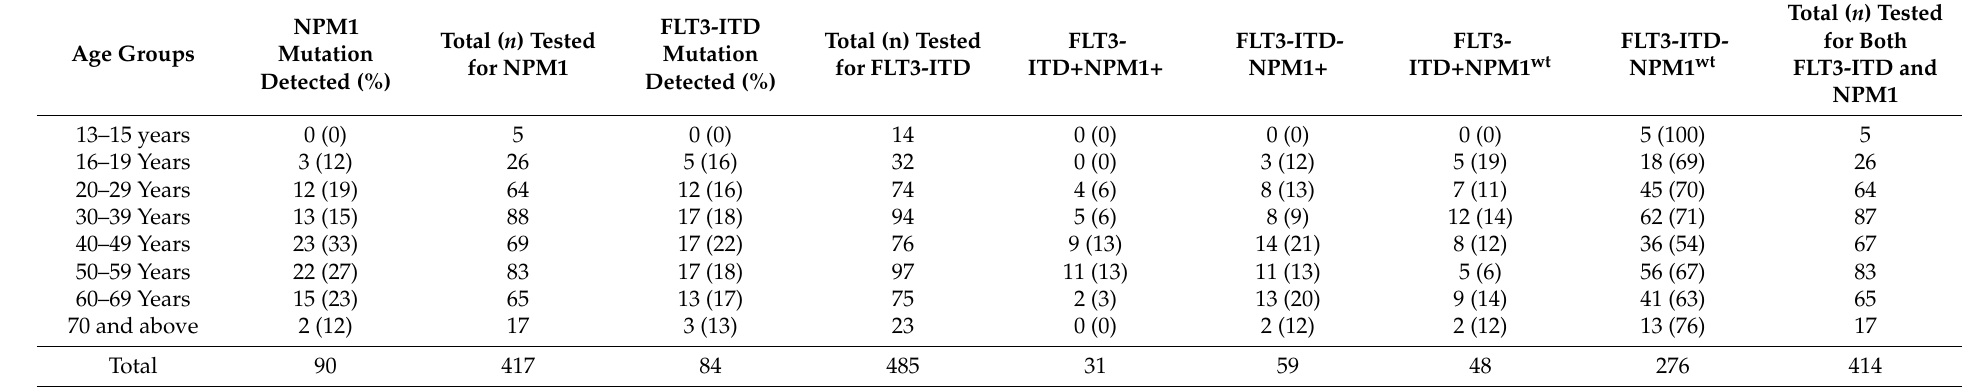
Table 5. FLT3-ITD and NPM1 mutation distribution by age a